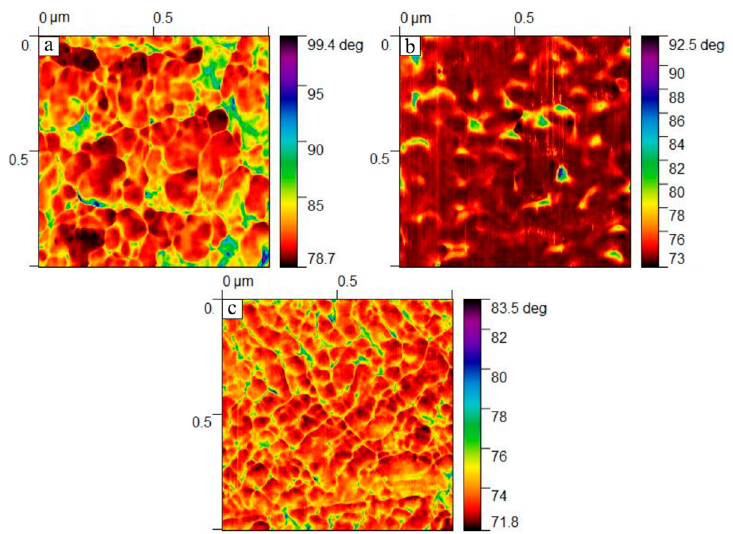
Figure 5. Quantitative elemental EDS analysis of NiTi with hydroxyapatite coatings.